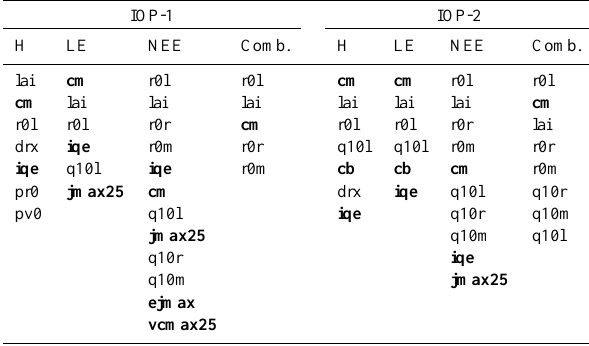
Table 4. Sensitive parameters for the sensible (H) and latent heat flux (LE) and the net ecosystem exchange (NEE), ranked by the Kolmogorov-Smirnov coefficient, for the single-objective and com- bined coefficient of efficiency for the 10% best runs. “Internal” pa- rameters for the plant physiological subroutine are printed in bold. For the meanings of parameter abbreviations see Table